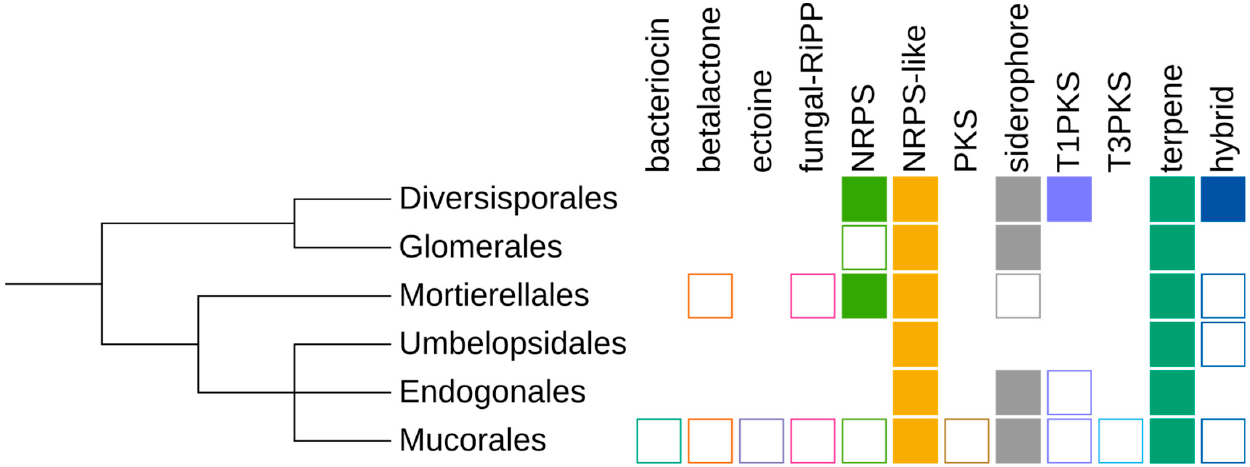
Figure 2. Schematic summary of the taxonomic distribution of particular secondary metabolite cluster (SMC) types. Filled rectangles, clusters of this type are present in more than 50% of isolates of the taxon; empty shape, in less than 50% of isolates; no shape, no clusters.